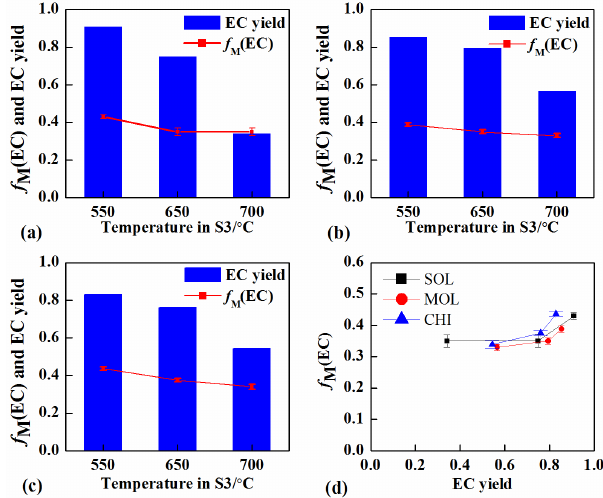
Fig. 7. Influence of S3 temperatures in the Swiss 4S protocol on EC yields and fraction of modern of recovered EC in S4 ( f M (EC)) from the analysis of the water-extracted winter samples SOL (a) , MOL (b) and CHI (c) and f M (EC) as a function of different EC yields (d)